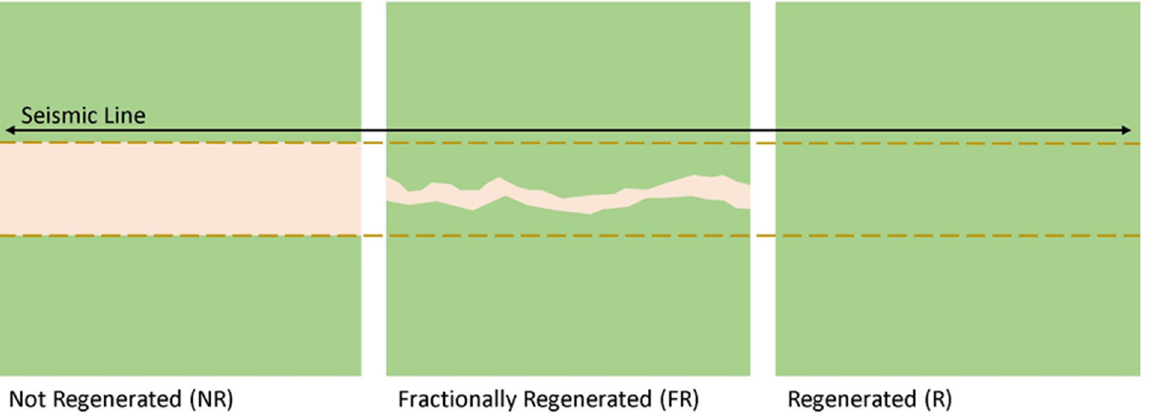
Figure 2. Schematic of each classification category on a seismic line: Not Recovered (NR), Fractionally Recovered (FR), and Recovered (R). Dashed line represents the estimated initial width from the 2000 imagery. Green = Forested/vegetated area. Beige = Not forested/vegetated.